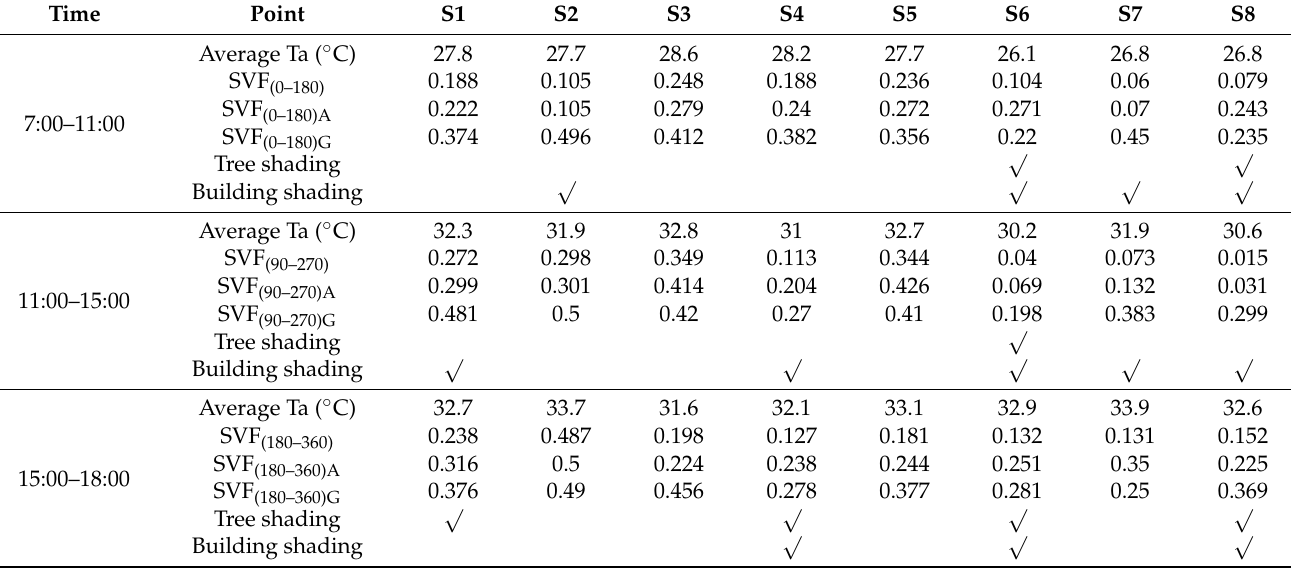
Table 6. Average Ta and shading characteristics of the eight observation points in Shuangqing